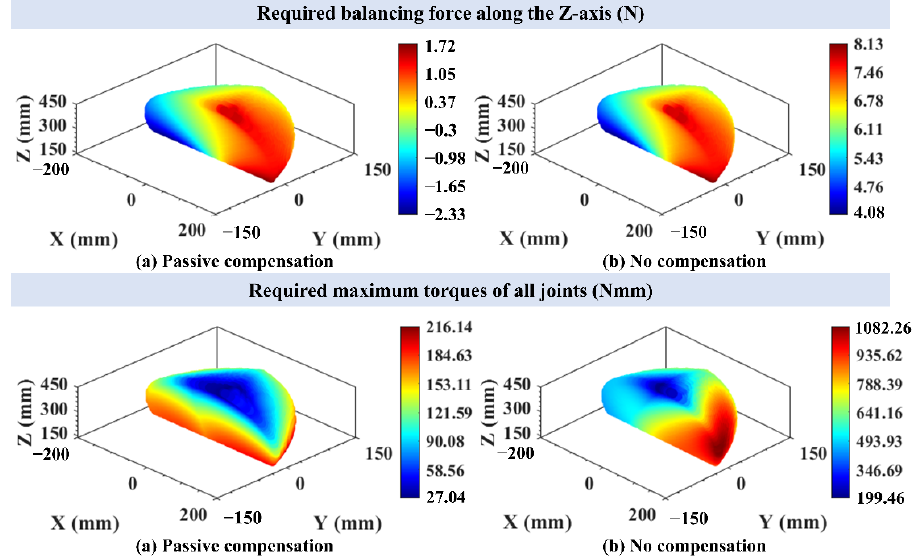
Figure 6. Results of no compensation and passive compensation.